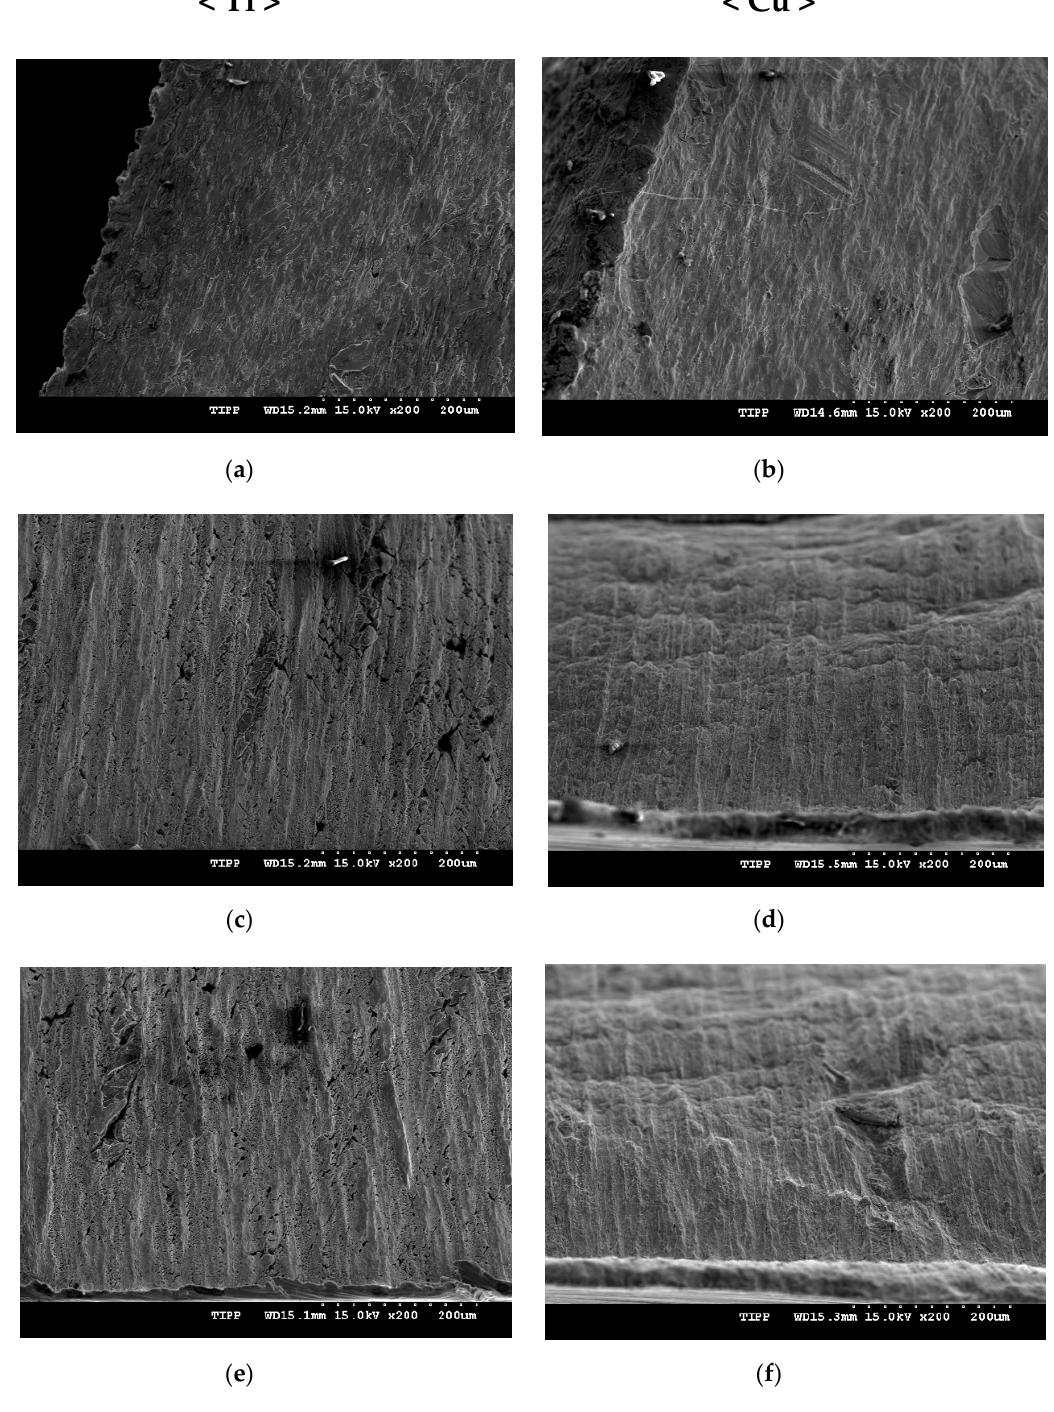
Figure 8. SEM images of the fracture surface in the interface-section of the clad after the tensile test: ( a , b ) as-rolled Ti, Cu sample; Ti, Cu sample annealed at 450 °C for ( c , d ) 2 h and ( e , f ) 4